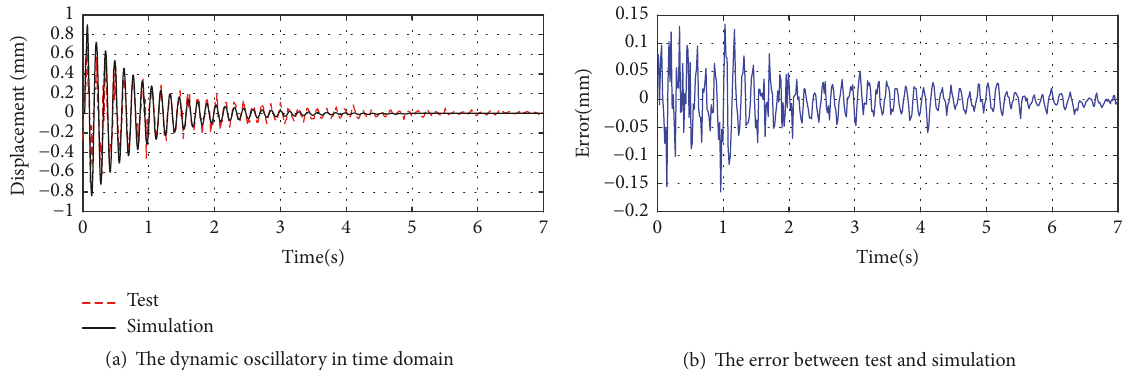
Figure 8: The comparison of the dynamic oscillatory of the sampling point.